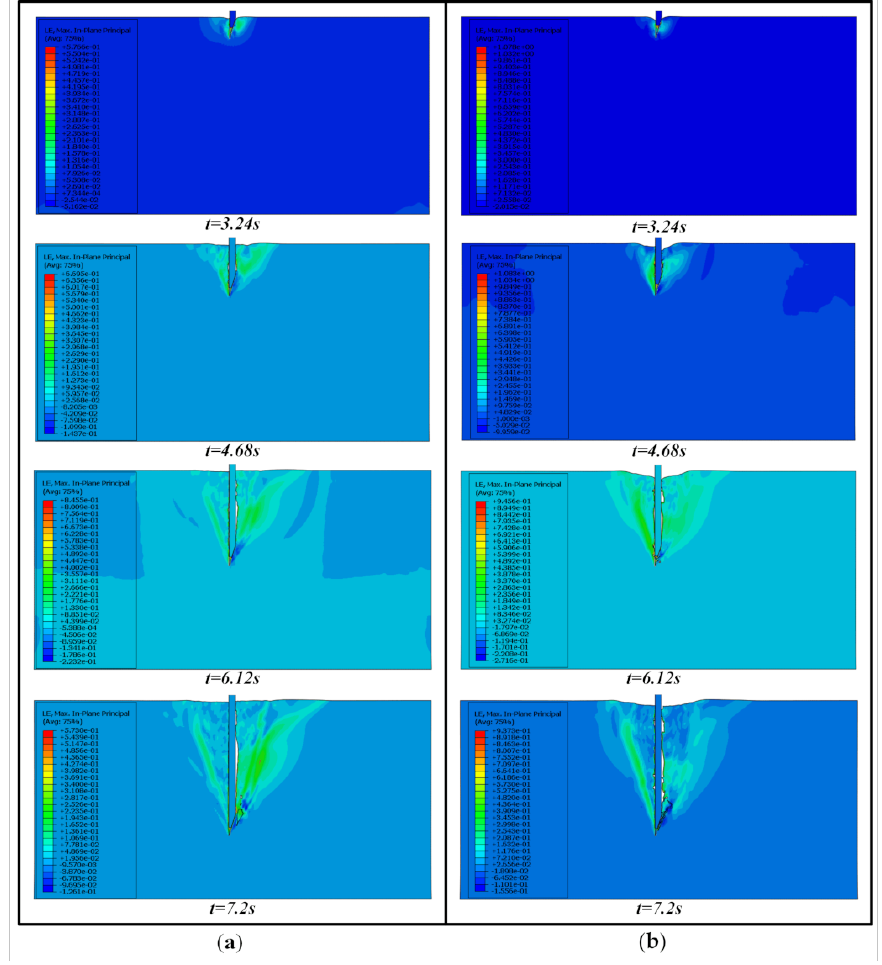
Figure 10. Strain contours of the biological soft tissue: ( a ) puncture process using a coated needle; ( b ) puncture process using an uncoated